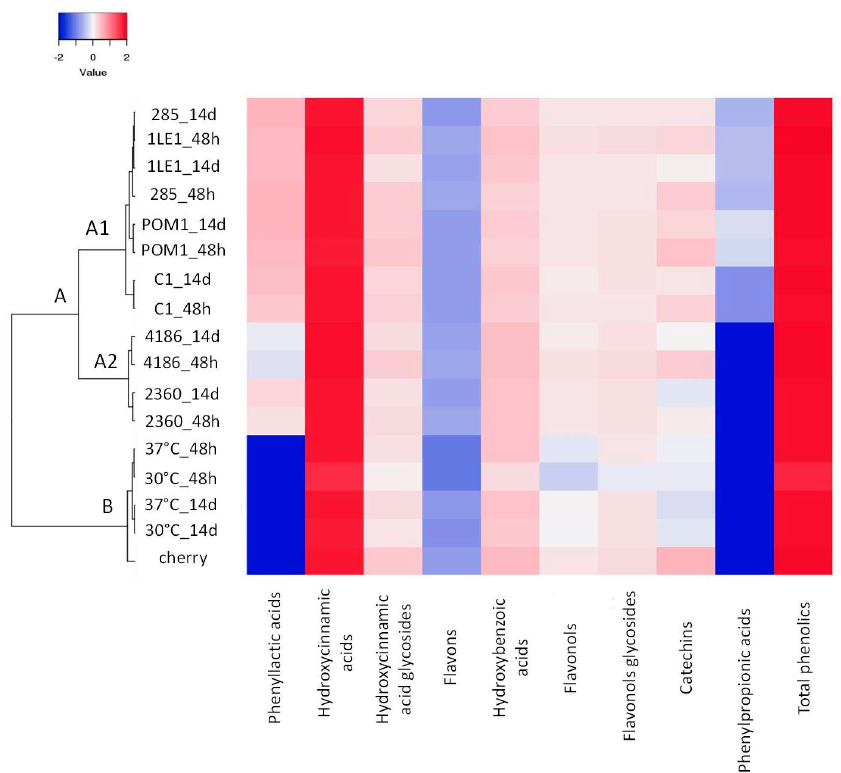
Figure 4. Phenolic compounds. Hierarchical clustering and heat map performed on phenolic compounds detected in fermented juice with L. plantarum (C1, 1LE1, POM1 and 285), L. rhamnosus (2360) and L. paracasei (4186) and unfermented juice (30 ◦ C and 37 ◦ C) after 48 h and 14 days (storage). A scale ranging from a maximum of 2 (red) and a minimum of −2 (blue) was used.